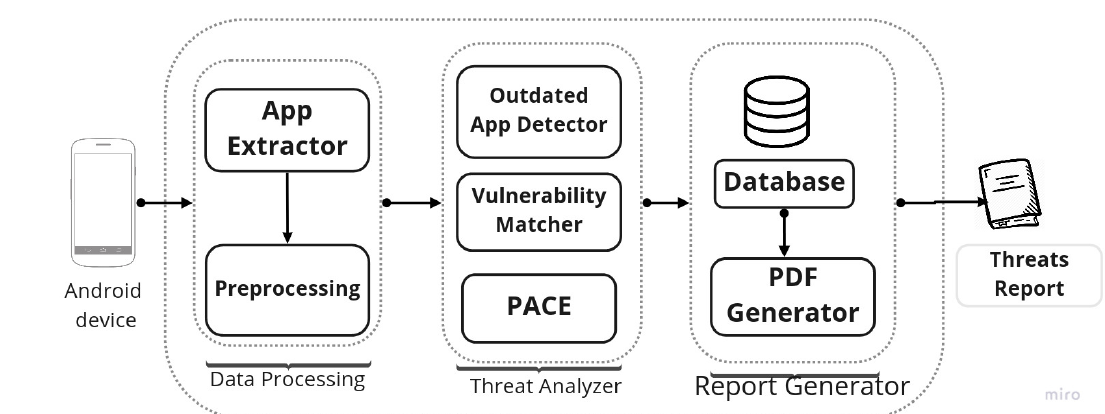
Figure 3. Block Representation of